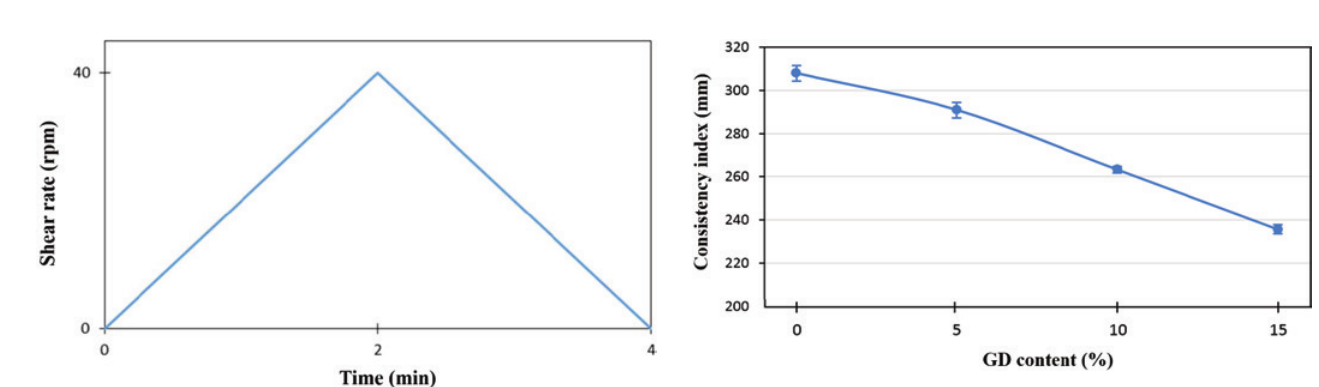
Test setup adopted for the flow test on the rheometer